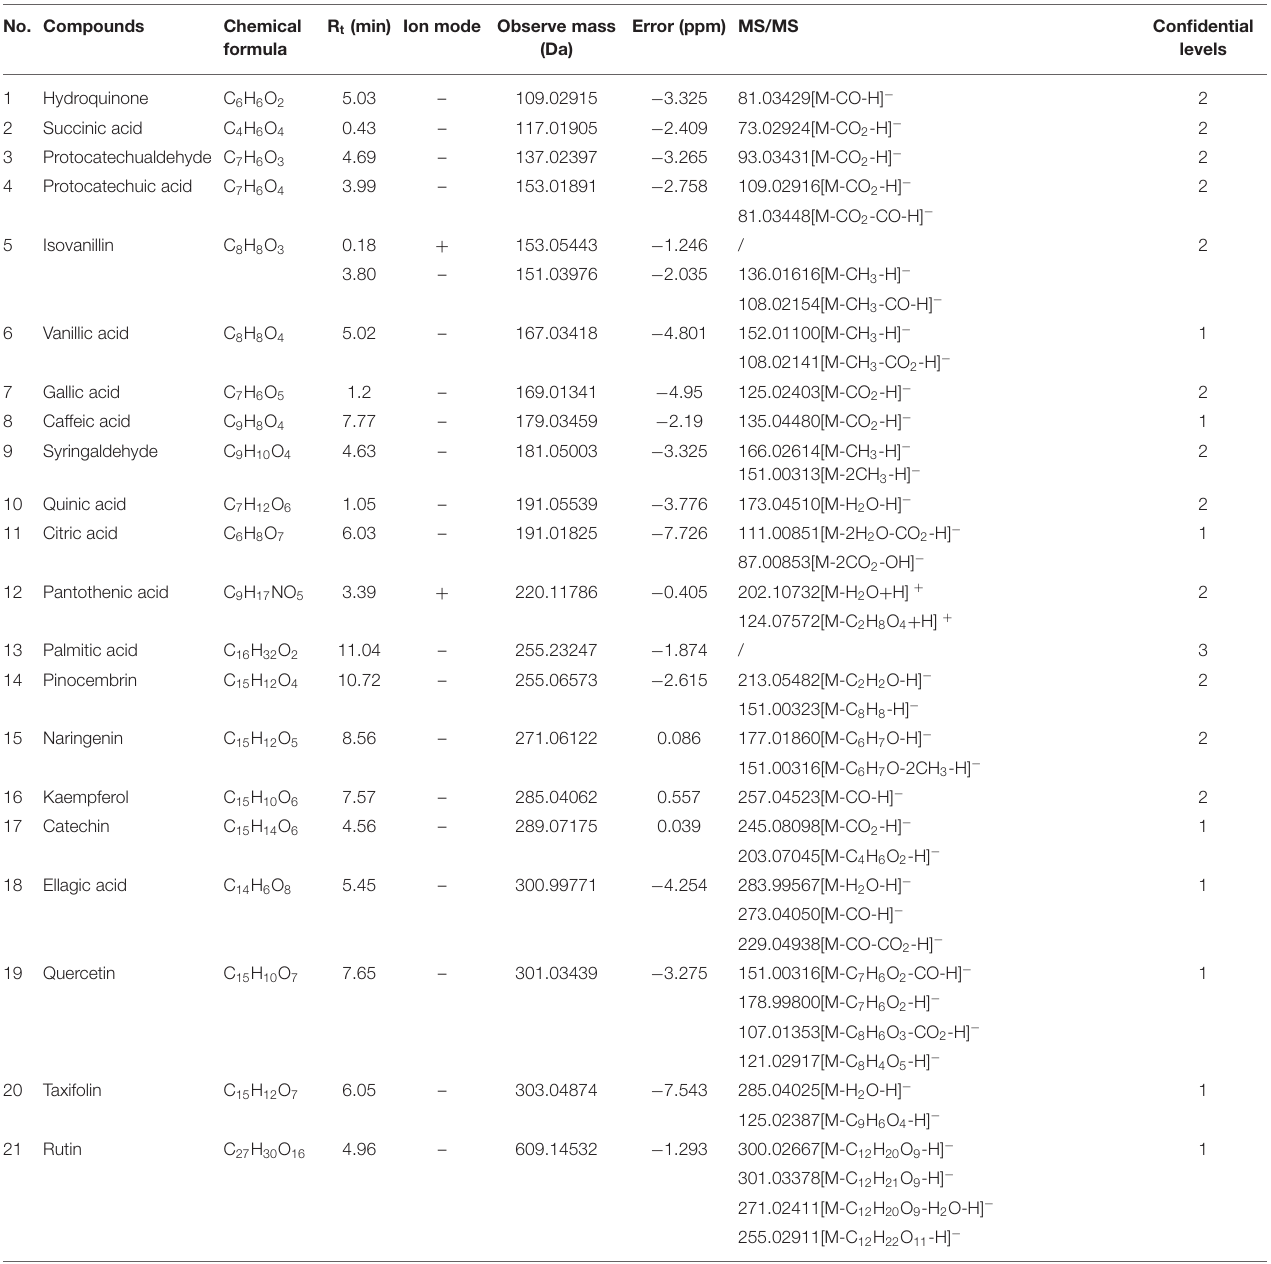
TABLE 2 | Identification of elution solution by UPLC-Q-Exactive Orbitrap-MS/MS. No.